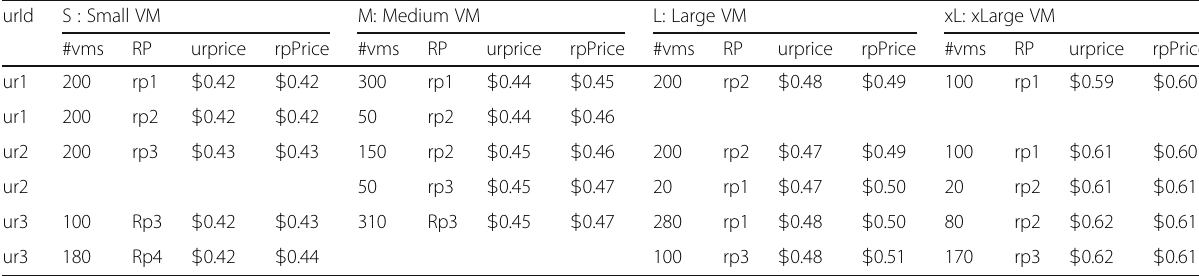
Table 3 A sample output of resource allocation done by the CMB urId S : Small